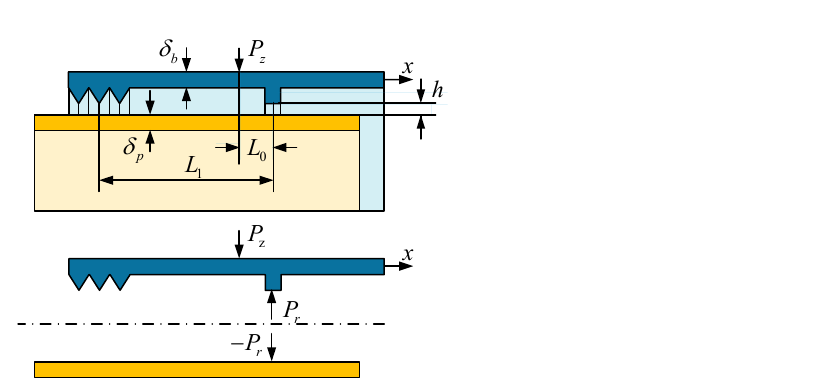
Figure 3. Free ‐ body diagram of the assembly subjected to the radial equivalent load, 𝑃 (cid:3053) . Figure 3. Free-body diagram of the assembly subjected to the radial equivalent load, P